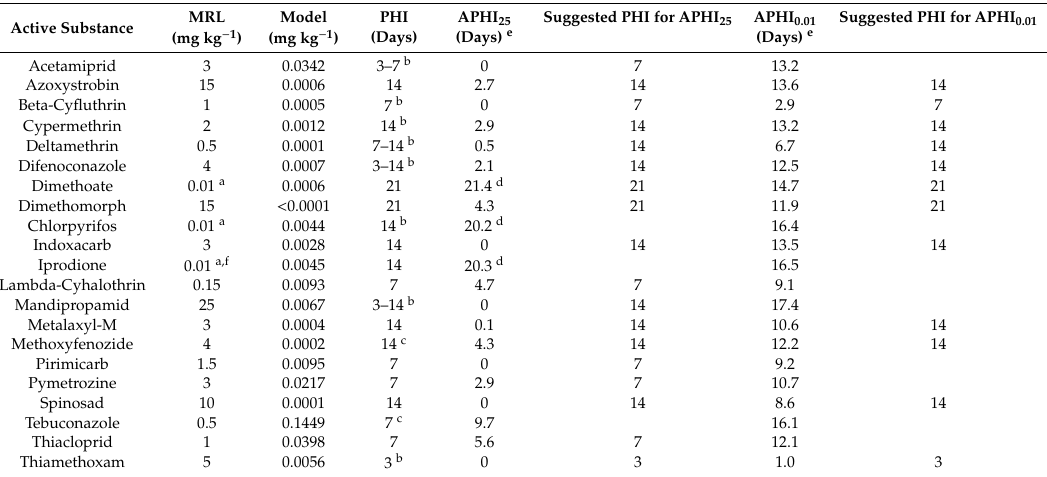
Table 2. Pesticide residues in iceberg lettuce modelled in terms of the corresponding pre-harvest interval (PHI) according to a list of registered products ([25] the action pre-harvest interval (APHI) was calculated for 25% maximum residue limit (MRL)(APHI 25 )) and a 0.01 mg kg − 1 limit (APHI 0.01 ). The MRL is cited according to the EU Pesticides Database